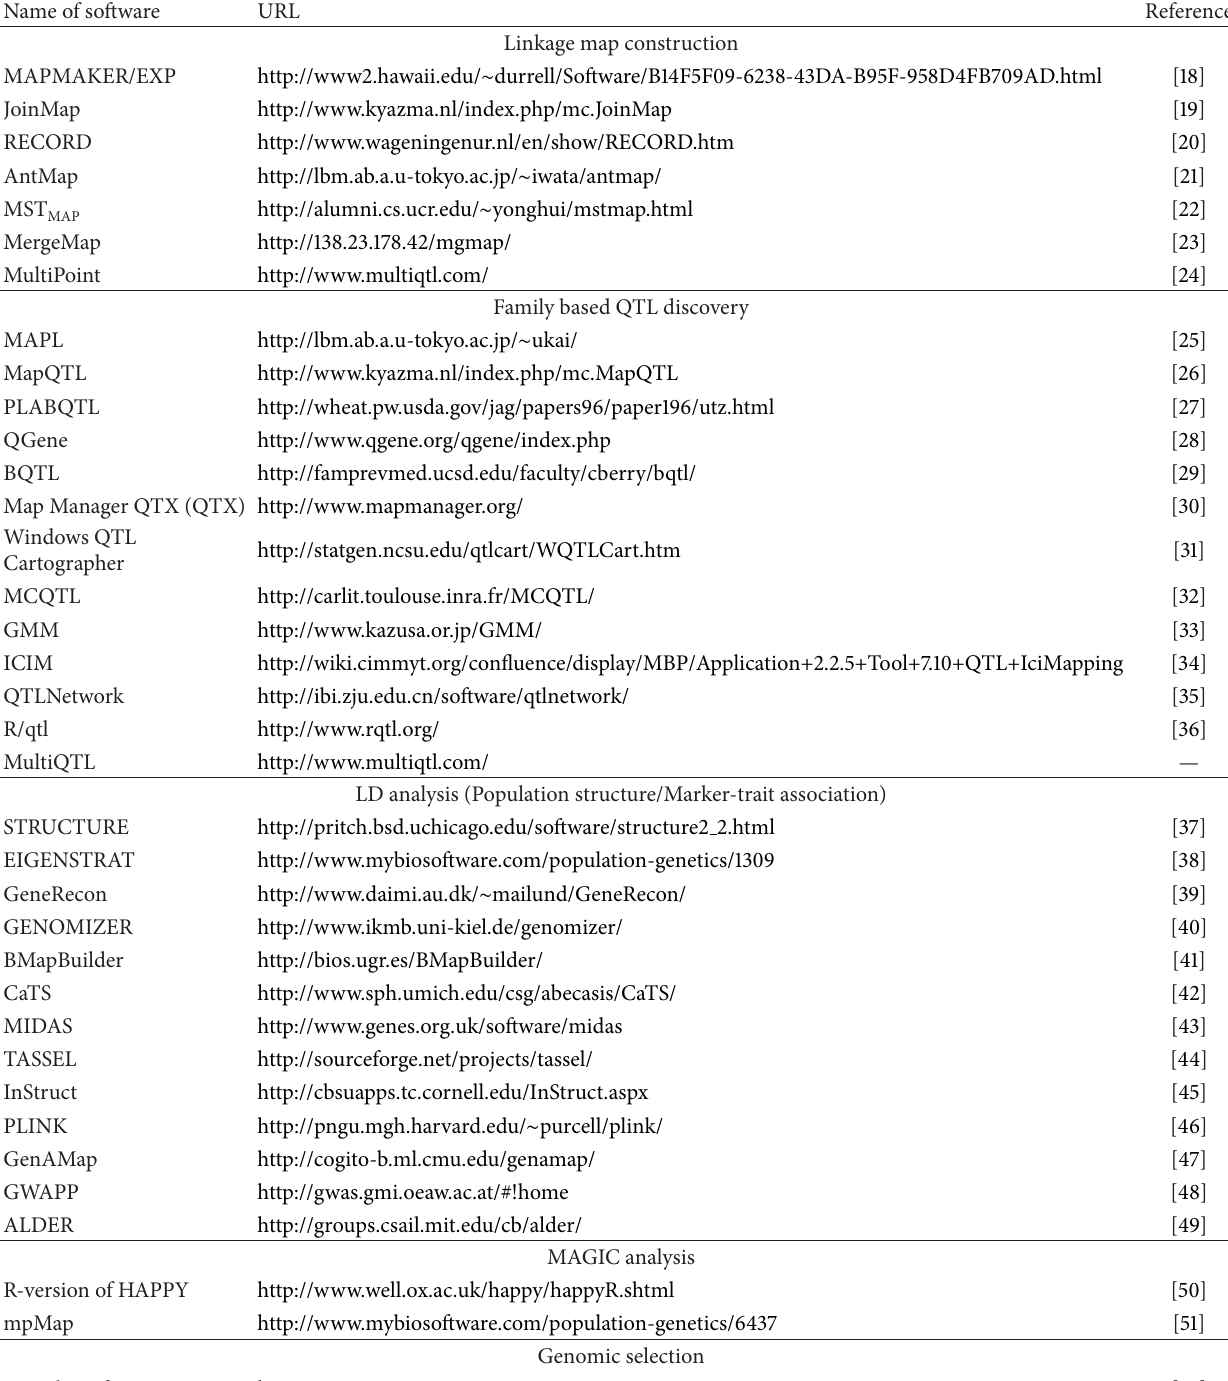
Table 1: List of softwares used for various analyses in molecular